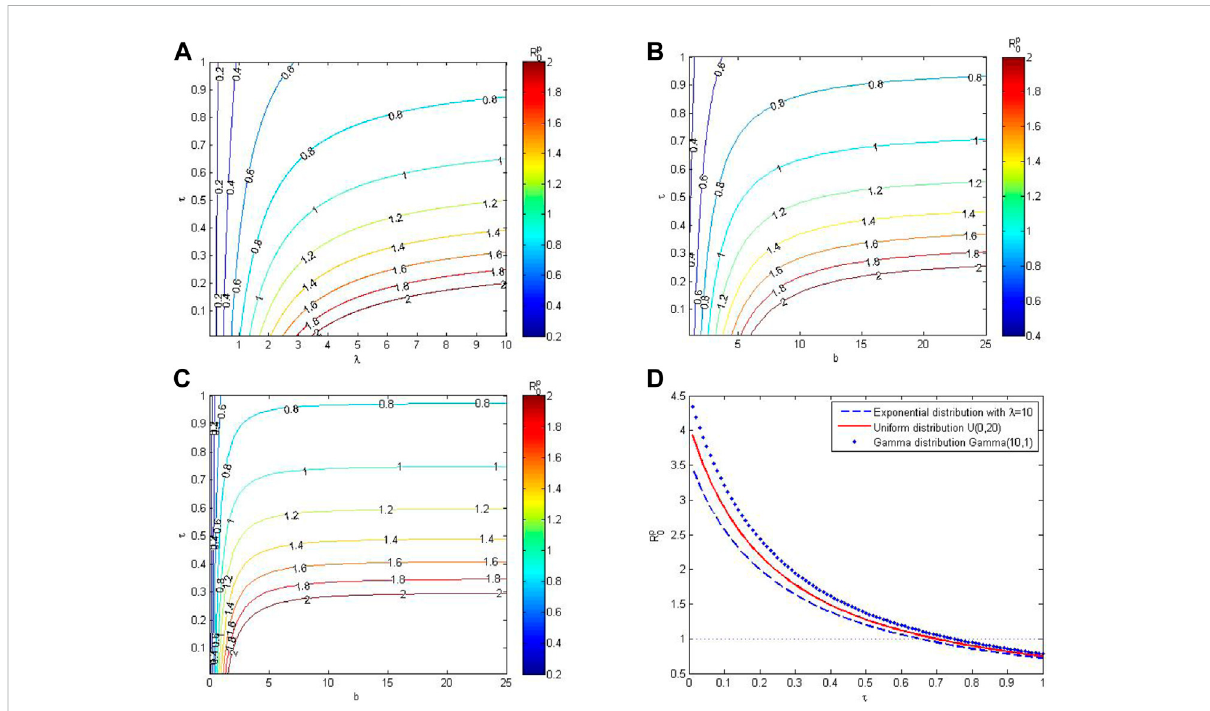
FIGURE 2 Effects of different contact tracing rates and awareness distributions on the basic reproduction number, R 0 . (A – C) Contours of R 0 as the functionoftracingrates anddistributionparameters. (D) The trendof R 0 as thefunctionoftracingratewhentheawarenessprocesseshavedifferent distributions but the same mean. In which, the variances of E (10), U (0, 20), and Gamma (10, 1) are 100, 100/3, and 10,